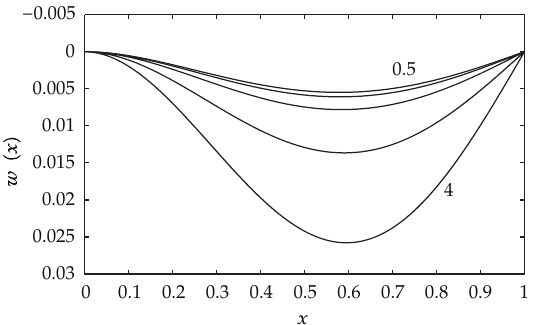
Figure 7: Graphs of the displacement w (cid:3) x (cid:4) for B (cid:5) 0 . 5 , 1 . 5 , 2 . 5 , 3 . 5 ,